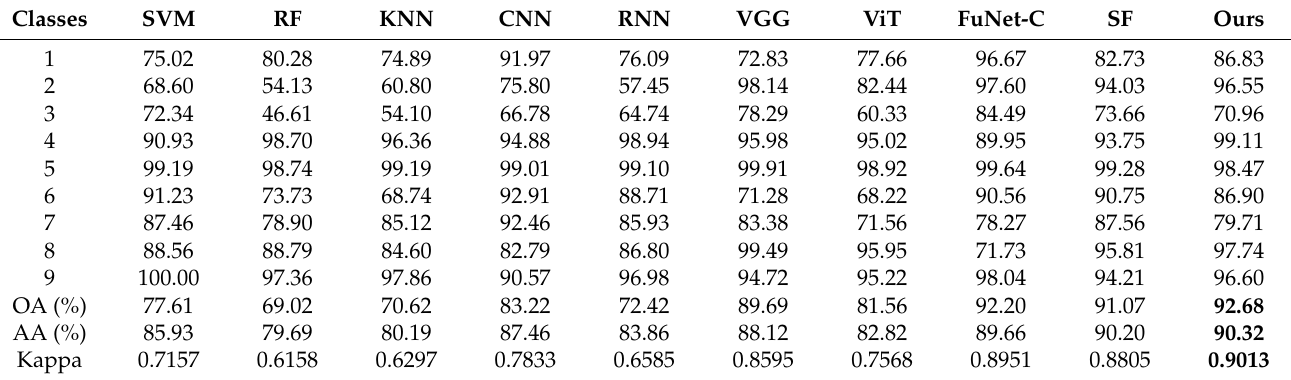
Figure 6. Visualization of the results of different algorithms on Indian Pines dataset. Table 7. OA, AA and kappa results of various algorithms on Pavia University